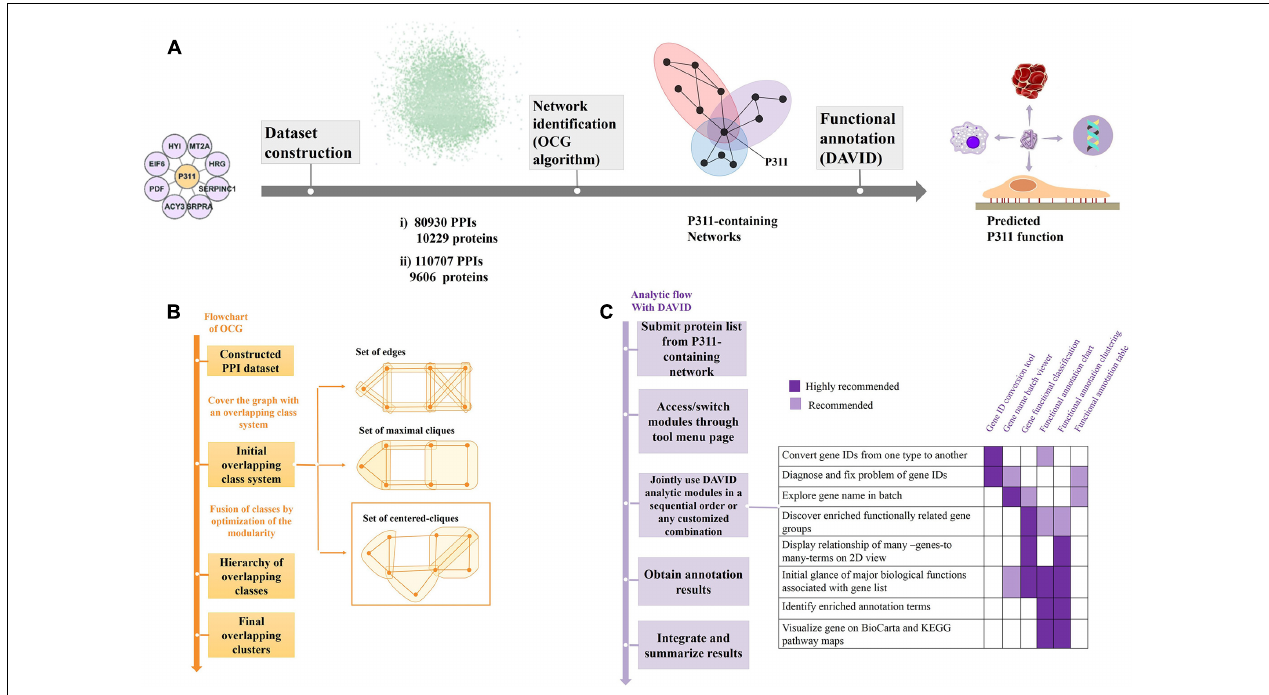
FIGURE 1 | Flow diagram of the bioinformatic analysis. (A) Flow diagram of OD2 approach. The initial P311-containing network identified in the Y2H screen (Peng et al., 2012) were integrated with the human PPI dataset gathered by Bossi and Lehner (2009) and dataset from the STRING database (Szklarczyk et al., 2014), separately. The resulting datasets were decomposed and identified the reconstructed P311-containing network using an OCG algorithm. The proteins in each reconstructed P311-containing network were analyzed with DAVID. Finally, predicted functions of P311 were identified. (B) Flowchart of the OCG (Overlapping Cluster Generator) algorithm. A graph was covered by the initial overlapping class system with centered cliques. Based on optimization of modularity of the partition, a hierarchy of nested clusters was built iteratively, leading to the final overlapping clusters (Becker et al., 2012). (C) Analytic flow with DAVID (Huang et al.,